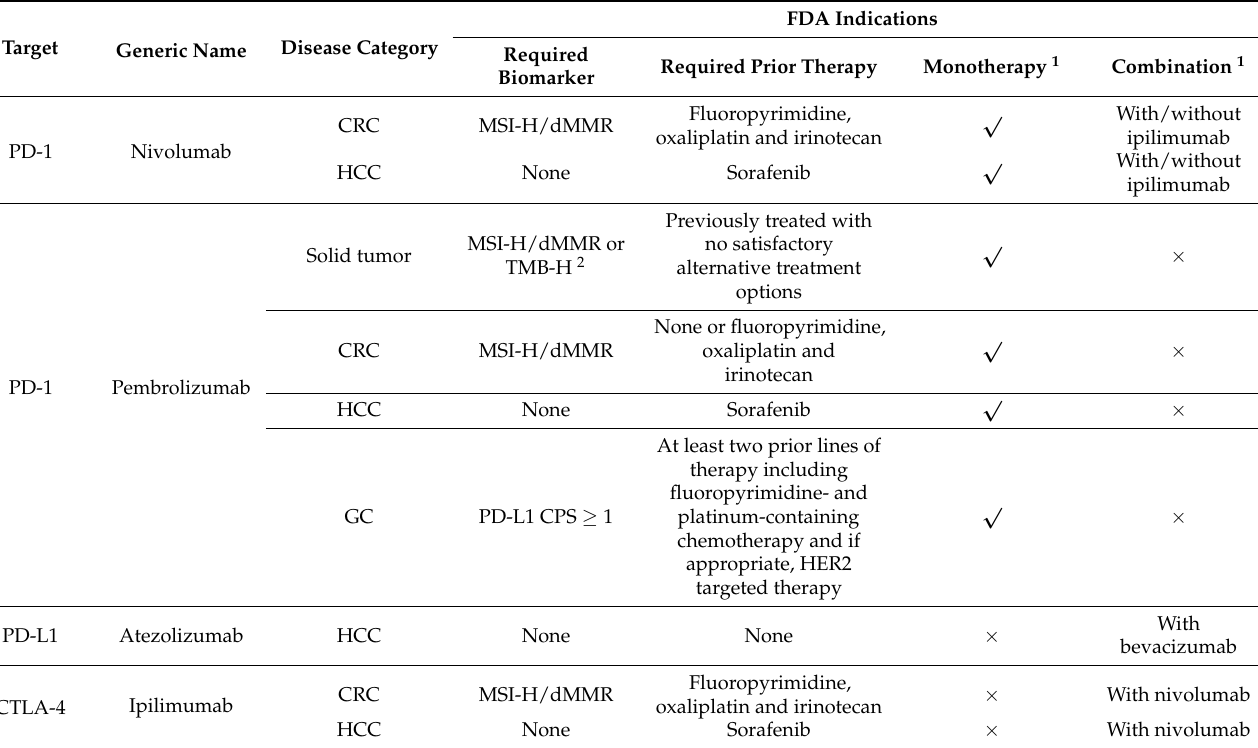
Table 1. Major classes of immune checkpoint inhibitors indicated for gastrointestinal